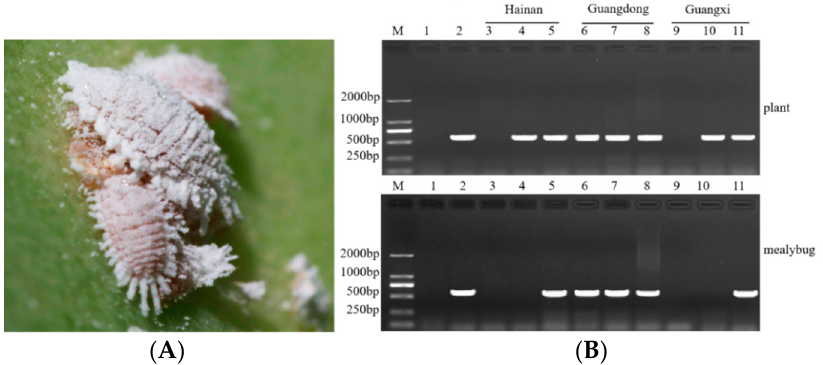
Figure 5. ( A ) Mealybugs infesting leaves of sisal. ( B ) Results of phytoplasma amplified from